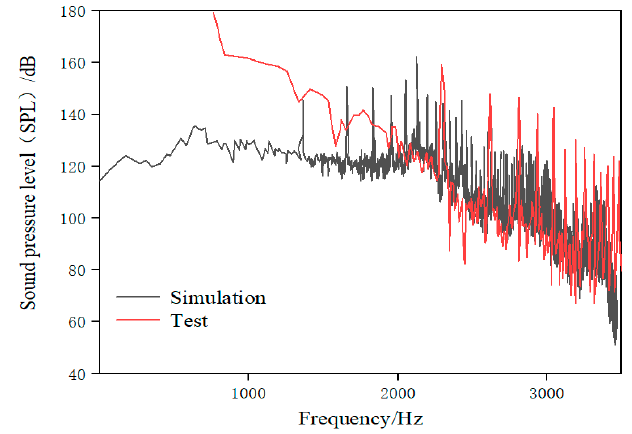
Figure 9. Sound pressure level under rated operating